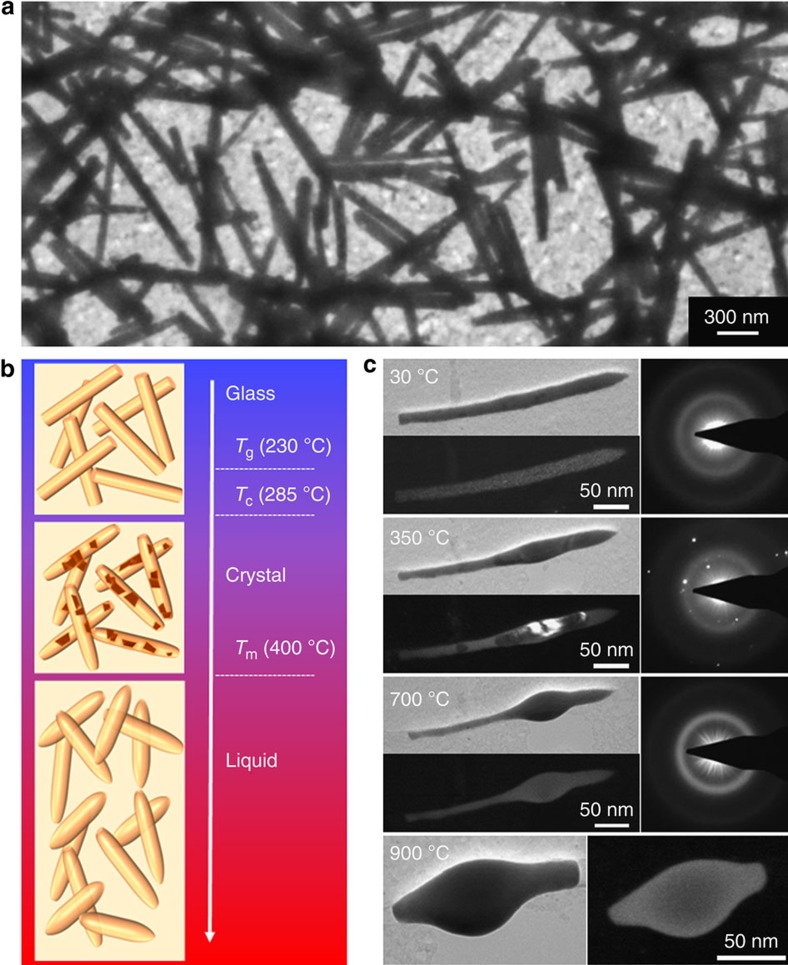
Phase transition of MG nanorods under in-situ TEM.(a) TEM image of MG nanorods pressed into a nanomold with 55-nm-diameter holes. They are drop casts on a thin ceramic film, which gets heated inside TEM. (b) Schematics for the morphological change of MG nanorods at different stages of in-situ heating. As-pressed nanorods exhibit uniform TEM image contrast (first panel). As temperature increases above crystallization temperature, Tc, crystalline grains start to grow in MG nanorods (dark brown in the second panel). The grains are identified by TEM imaging or electron diffraction. As temperature increases above the melting temperature, Tm, the crystallized nanorods turn to liquid phase (third panel). (c) TEM characterizations of a nanorod under in-situ heating. At 30 °C, the nanorod is amorphous, confirmed by the uniform TEM image contrast (top left: BF image, bottom left: DF image) and a diffusive ring pattern in SAED (right panel). Above Tc at 350 °C the nanorod is largely crystallized, reflected in contrast changes in the TEM images. The crystalline phase appears dark for BF (top left) and bright for DF (bottom left) TEM images, respectively. The corresponding SAED displays diffraction spots, indicating the presence of crystalline grains (right panel). At 700 °C, which is above Tm, uniform TEM image contrast and diffusive SAED ring similar to those at 30 °C are observed to indicate that the nanorod is back to disordered state. As heating progresses with longer time, the nanorod becomes significantly deformed. At 900 °C, the nanorod becomes greatly shortened and balled-up.